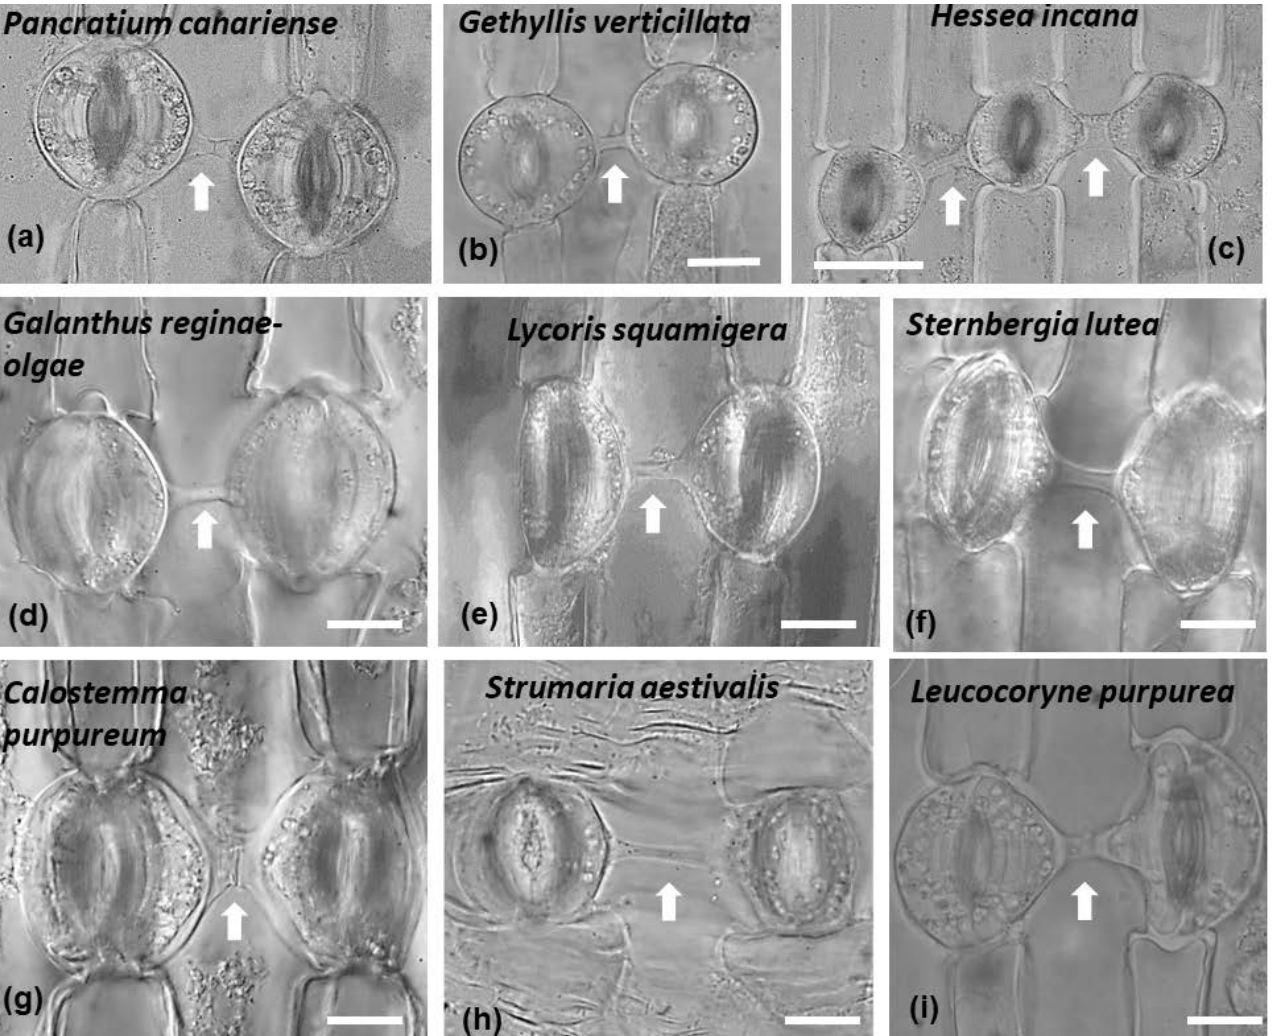
Figure 13. Connected stomata in leaves of representative species (the name is given on each panel) of the three subfamilies of Amaryllidaceae: Amaryllidoideae, Allioideae and Agapanthoideae. Stomata appear connected in pairs ( a , b , d , e , f , g , h , i ) and sometimes triplets exist ( c ). Arrows point to cell wall connection strands. Scale bar: 20 μm.